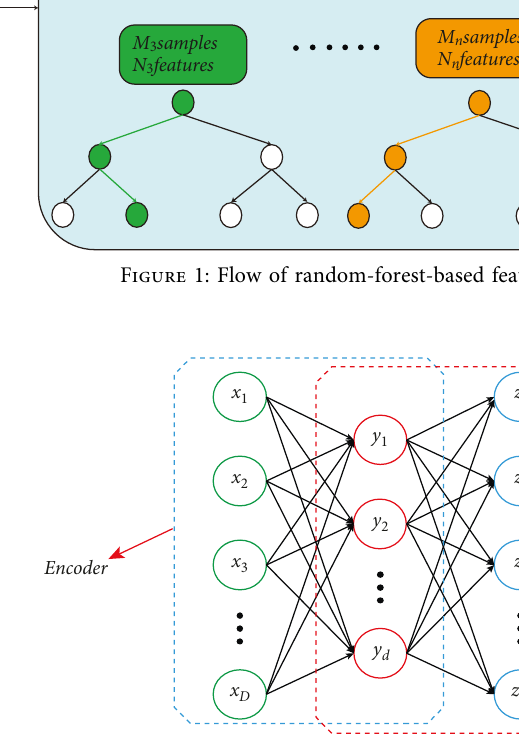
Figure 2: Autoencoder network